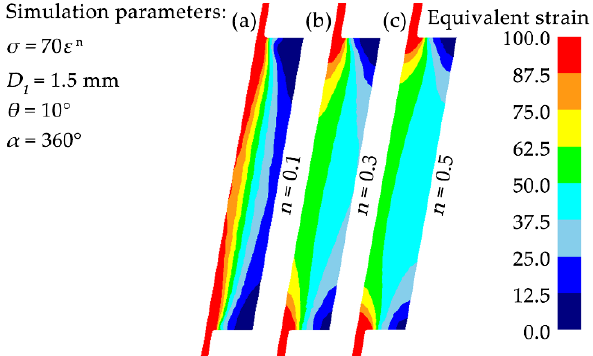
Figure 7. Distribution of equivalent strain across the vertical section of samples with various strain-hardening exponents during t -HPS: ( a ) n = 0.1; ( b ) n = 0.3; ( c ) n = 0.5.